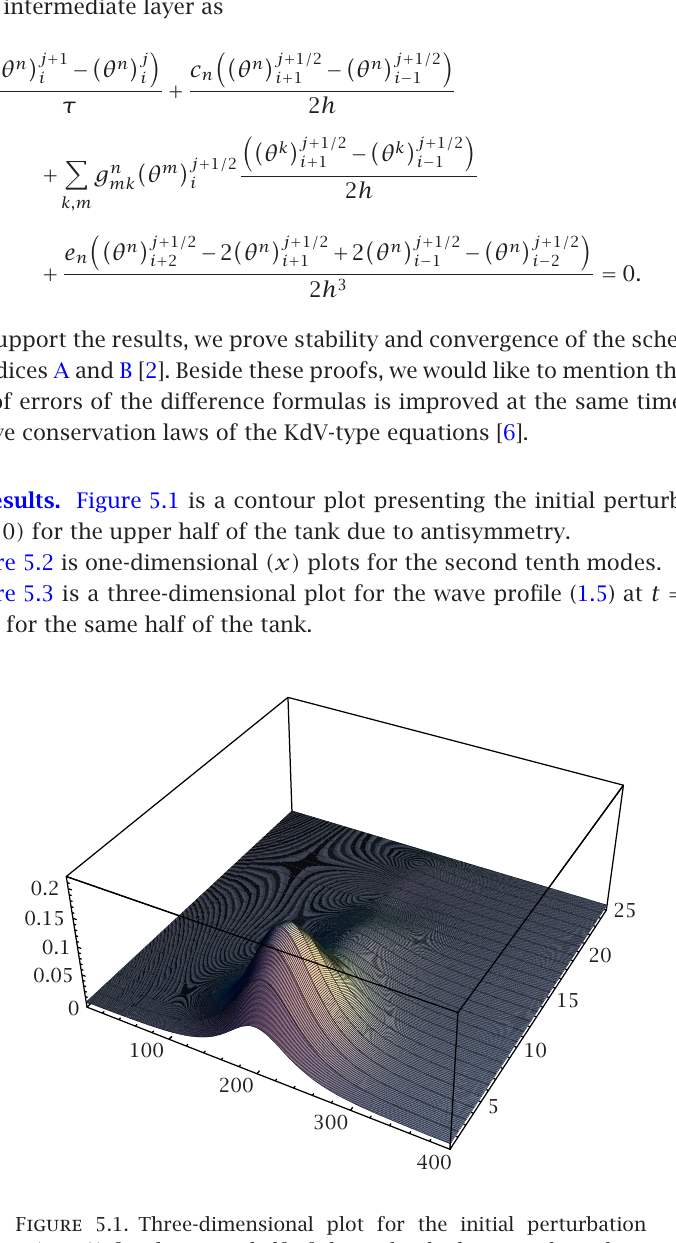
Figure 5.1 . Three-dimensional plot for the initial perturbation ψ(z,x, 0 ) for the upper half of the tank. The horizontal numbers ( 25 , 400 ) indicate the number of mesh points used in plotting in x and z directions while the dimensions are 12.5cm in z and 50cm in x ,